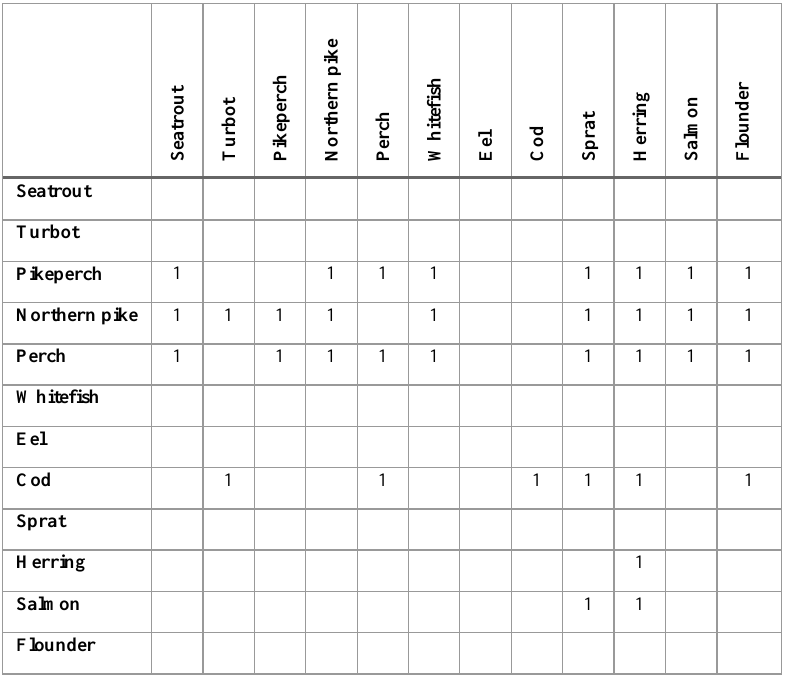
Table A3. Ecological network used in the social-ecological analysis. Predator species are placed in rows and prey species in